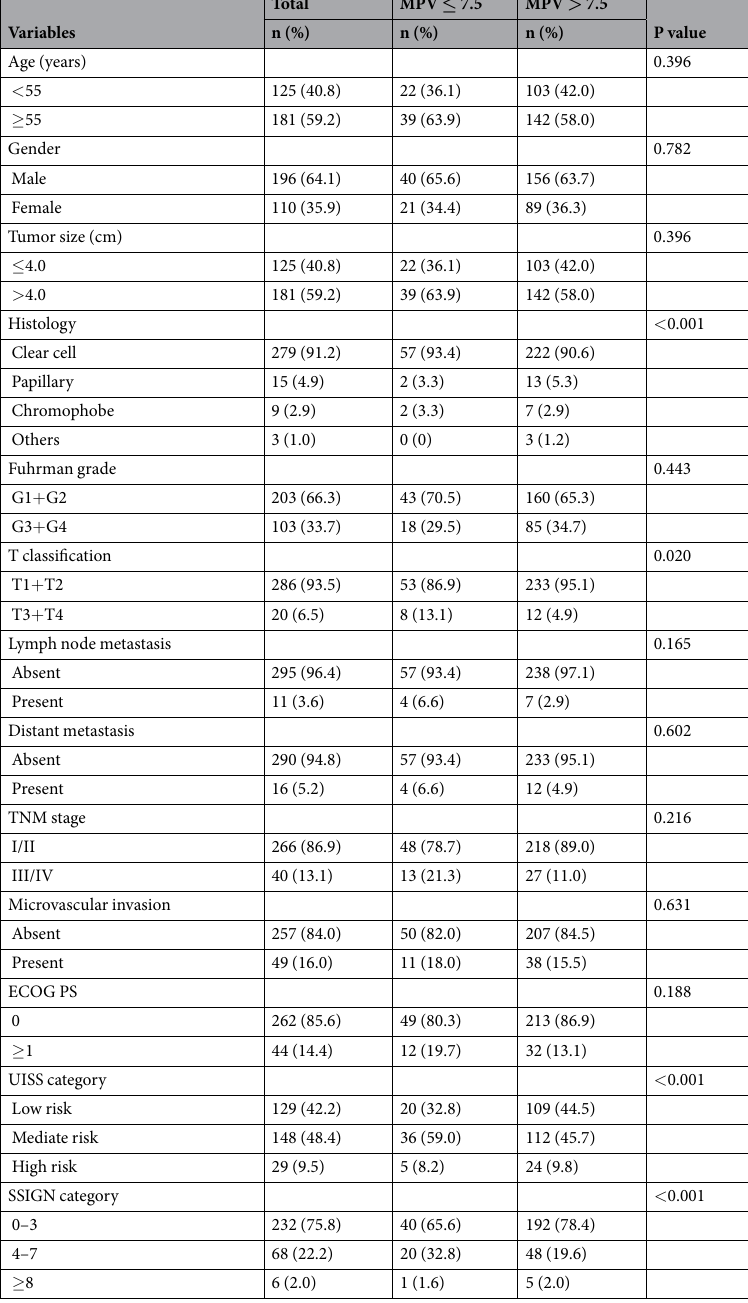
Table 1. Baseline characteristics of patients with renal cell carcinoma according to MPV